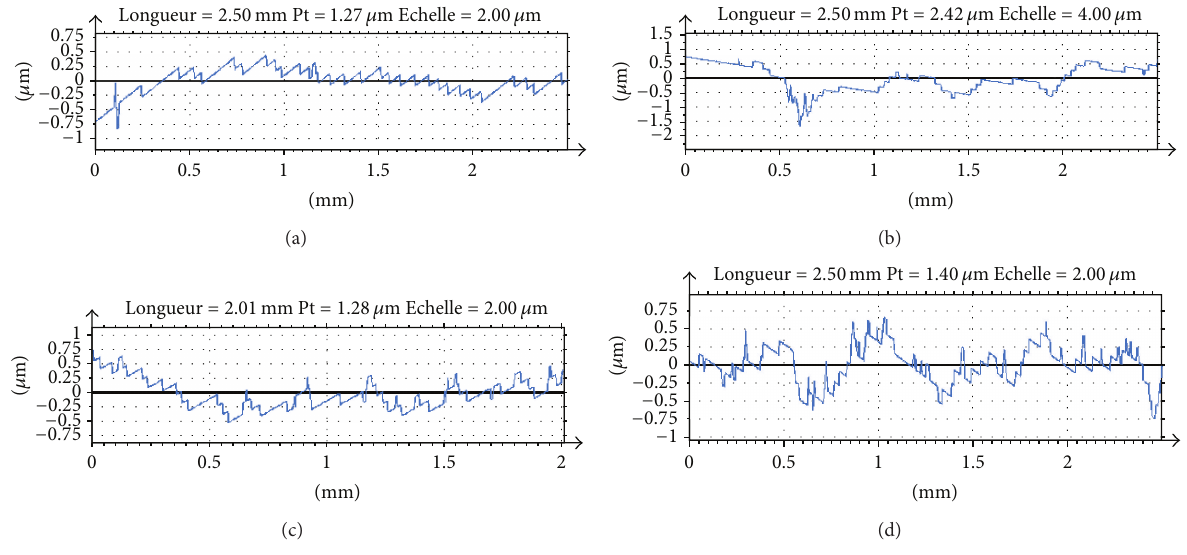
Figure 2: Surface profiles of the different primers/topcoat: (a) SP, (b) DP, (c) PP, and (d) AP.